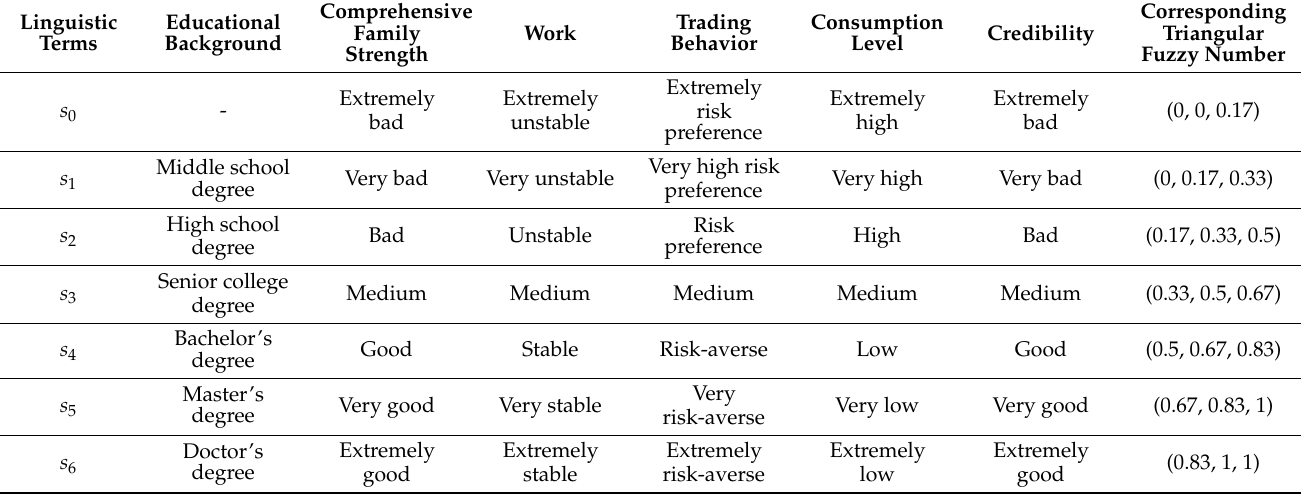
Table 3. Linguistic terms of fuzzy linguistic variables and their corresponding triangular fuzzy numbers. Linguistic Educational Terms